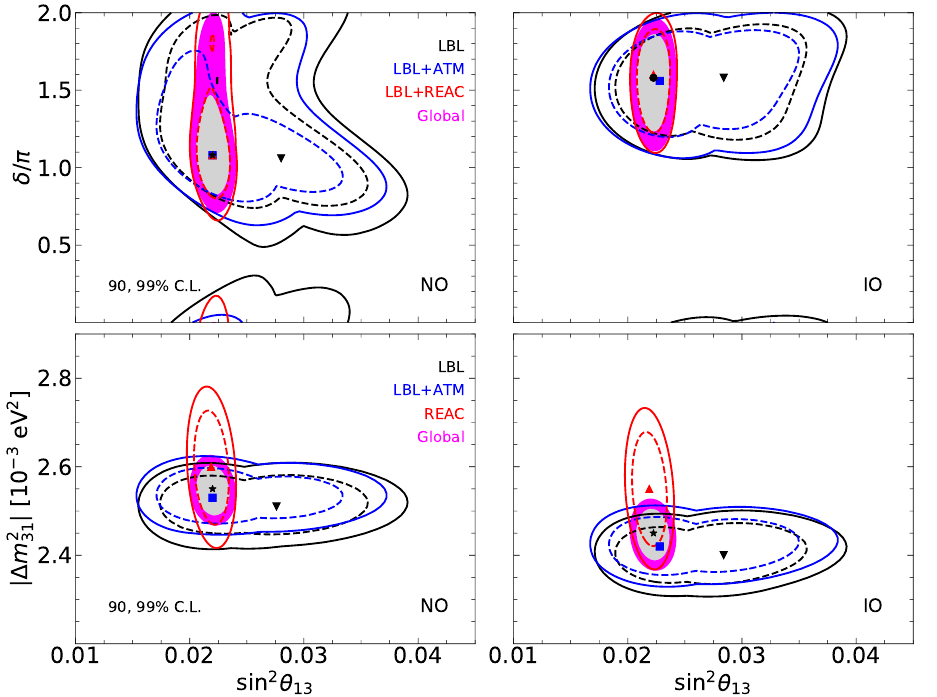
Figure 9 . Allowed regions in the sin 2 θ 13 - δ and sin 2 θ 13 - ∆ m 2 planes from several data-set com- 31 binations: long-baseline accelerator experiments (black lines), accelerator and atmospheric data (blue), accelerator and reactor data (red, upper panels), reactor data (red, lower panels) and global analysis (colored regions). The down-triangle, square and up-triangle correspond to the best fit values obtained from the combination of data sub-sets, while the black star (left panel) and black dot (right panel) denote the best fit value obtained from the global fit for normal and inverted ordering,